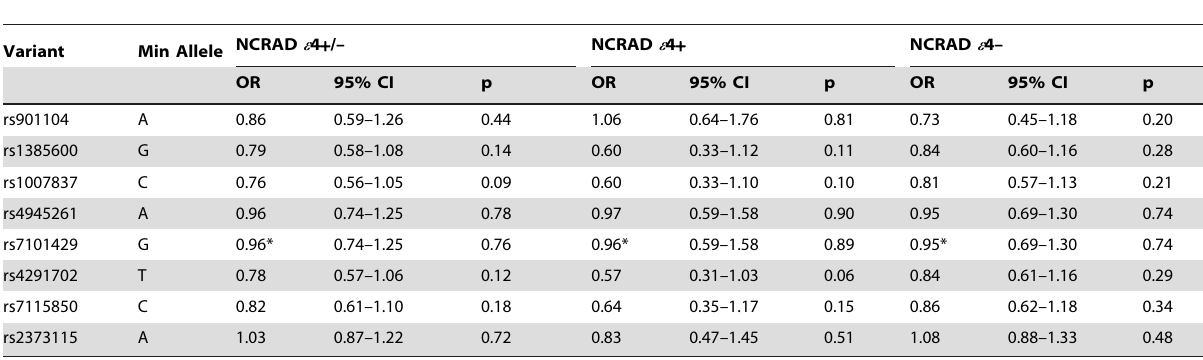
Table 3. Single variant association of eight GAB2 variants with LOAD in the NCRAD